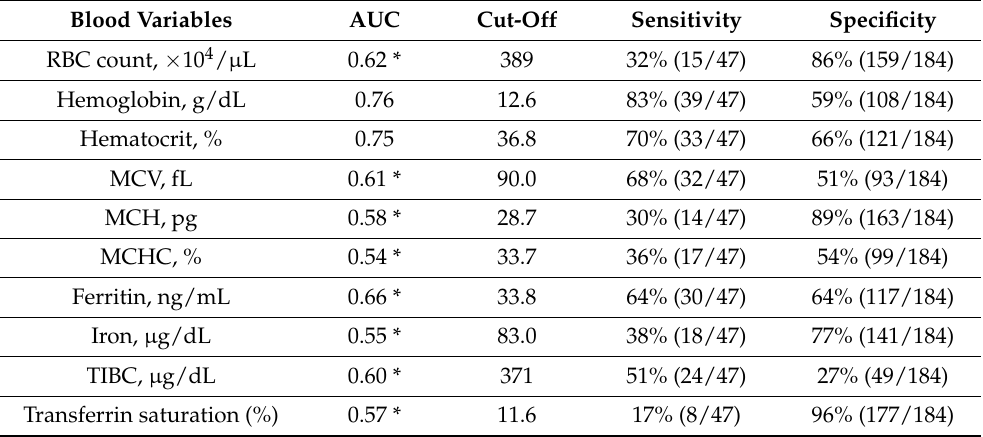
Table 4. Screening characteristics of optimal cut-offs suggested by Receiver Operating Characteristic for prediction of third trimester anemia. Blood Variables AUC Cut-Off